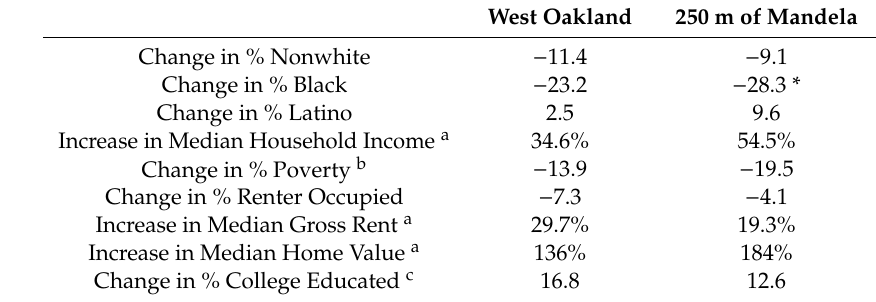
Table 2. Change in racial and socioeconomic composition between 1990 and 2010 for all tracts in West Oakland, and within 250 m of the Mandela Parkway